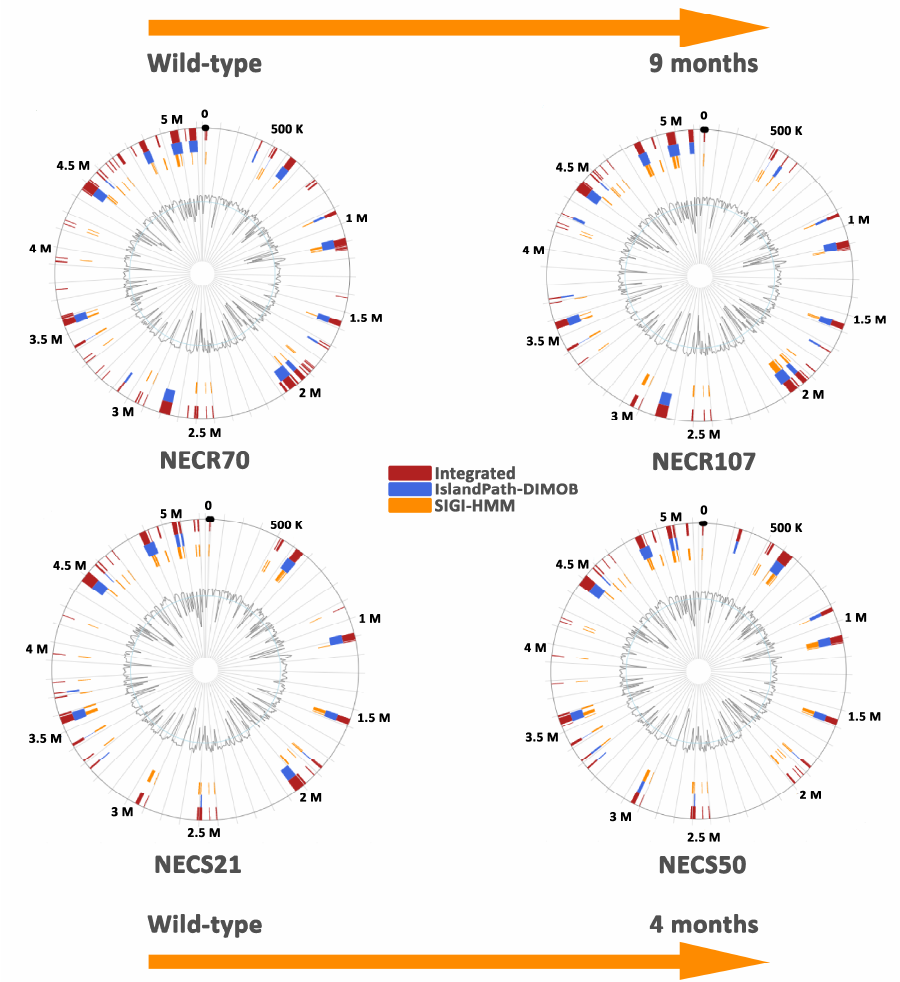
Figure 2. Prediction of pathogenicity islands within Escherichia coli genomes isolated from diabetic foot infections. Pathogenicity islands were predicted using IslandViewer 4, including three predic- tions methods Integrated, IslandPath-DIMOB, and SIGI-HMM (http://www.pathogenomics.sfu.ca/islandviewer (accessed on 28 January 2021)).